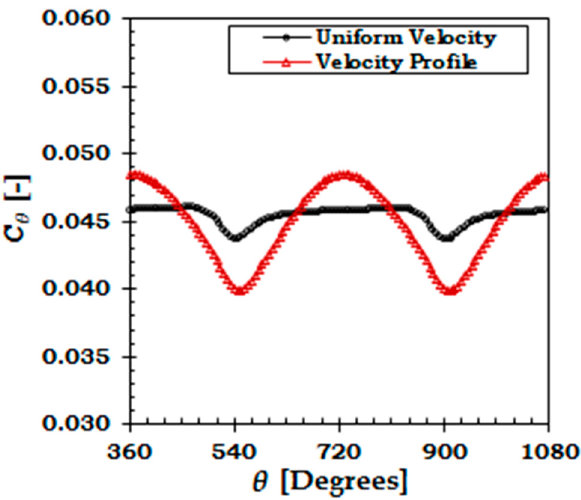
Figure 7. Rotor angular positions for the presentation of results.